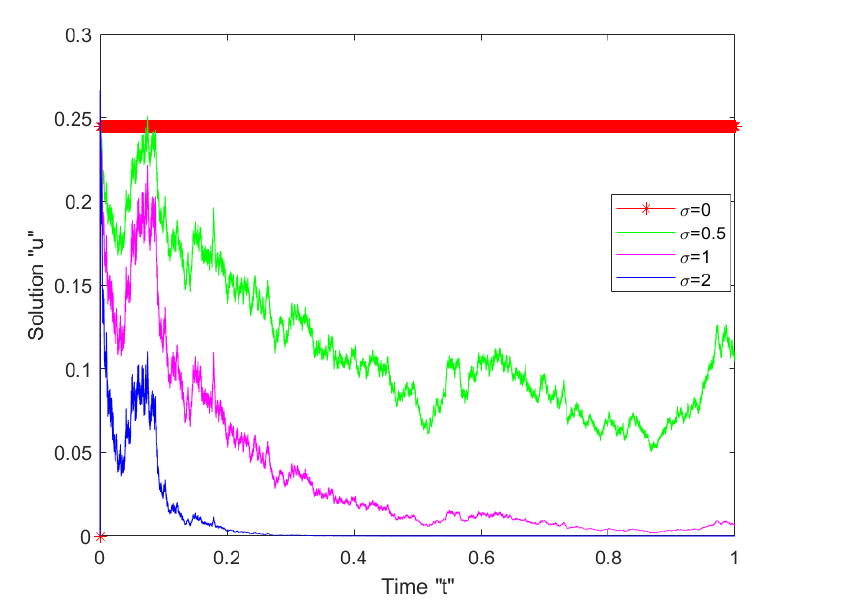
Figure 3. Profile picture of | U | given in (14) in two dimensions for α = 1 and different ρ =